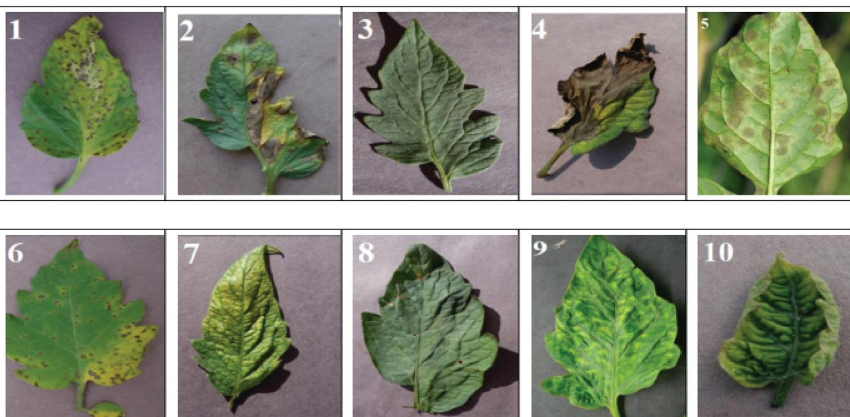
Figure 1: Sample images of diferent phenotypes of tomato plant.